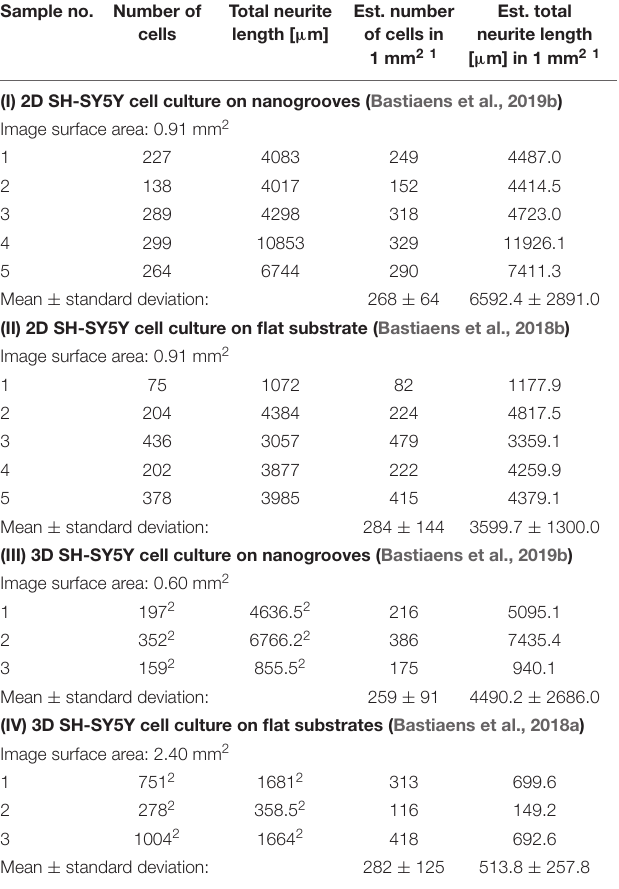
TABLE 1 | Parameter values derived from 2D and 3D SH-SY5Y cell cultures on nanogrooved and flat substrates. Sample no. Number of